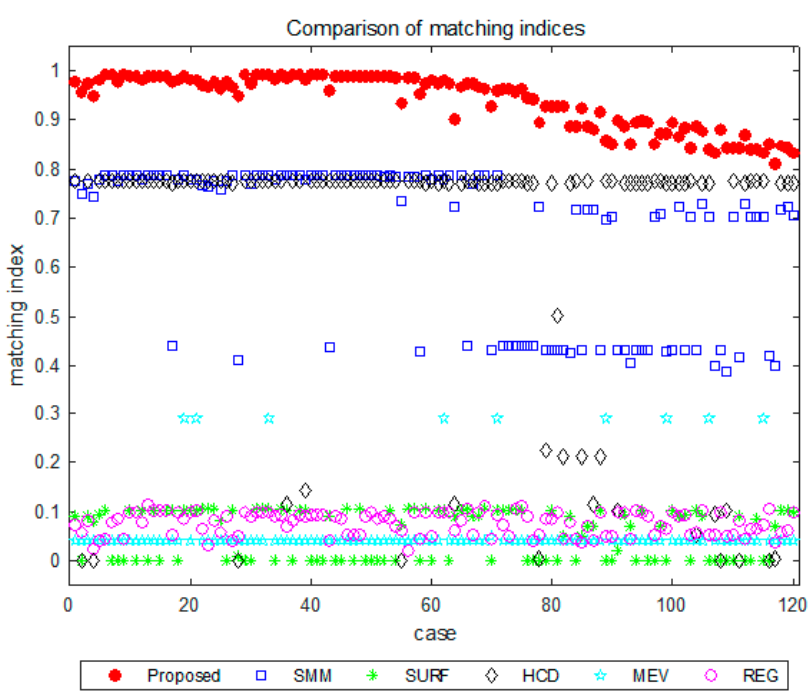
Figure 13. Comparison of matching indices with the proposed method and other methods according to the different pairs of individual maps produced from real experimental data. The matching indices with the proposed method were consistently higher than those with other methods. Table 2. Comparison of the averages and standard deviations of matching indices with different methods in simulations and experimental data.